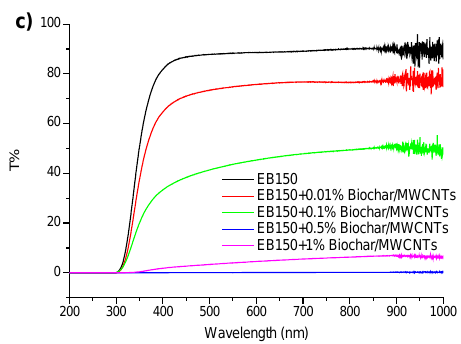
Figure 11. UV-Vis spectra of films containing ( a ) MWCNTs, ( b ) BC and ( c ) BC / MWCNTs in concentrations ranging from 0.01 to 1.00 wt %.